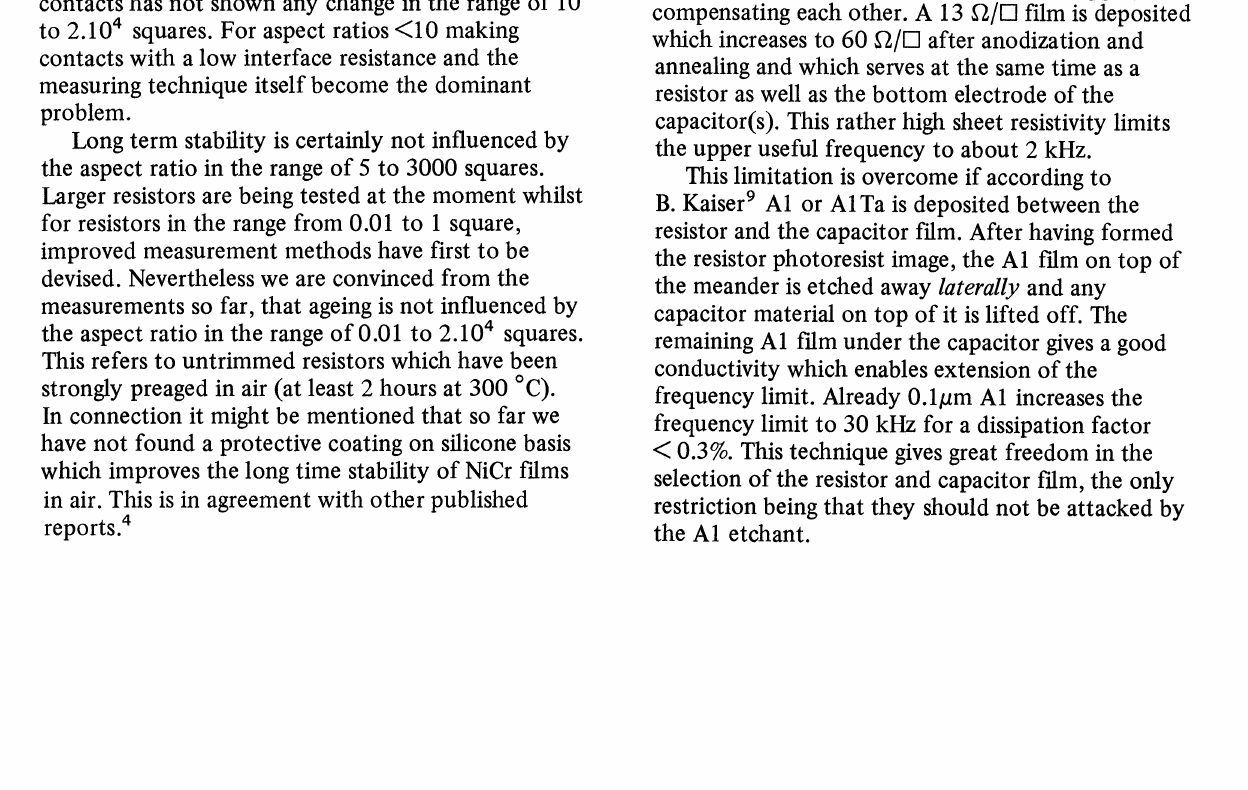
FIGURE 6 Histograms for TCR and Rr values from 58 batches (a, b) and from one batch (c, d) but latter not contained in (a, b). Number in upper left corner is the total of values